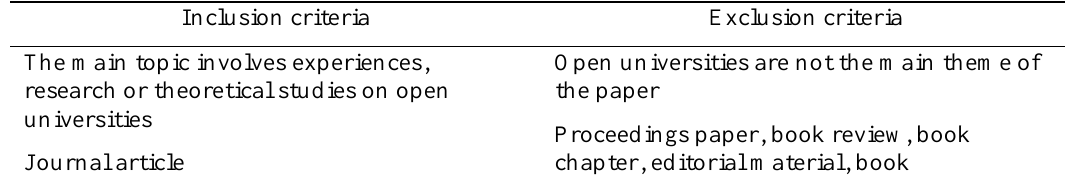
Inclusion and Exclusion Criteria Used in the Bibliometric Study Inclusion criteria Exclusion